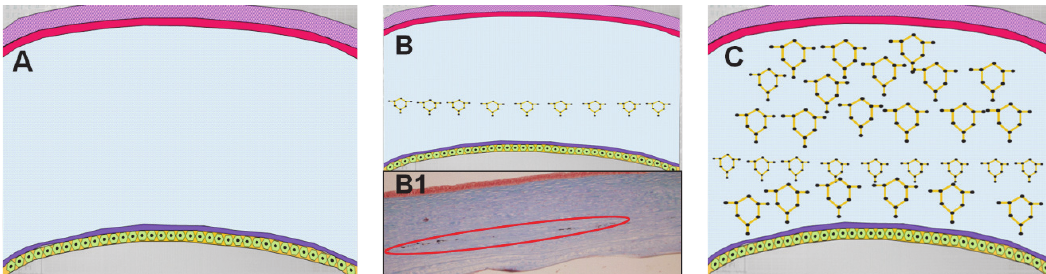
Figure 8: Schematic representation of a cross section of the cornea. (A) Cornea without carbon nanostructures. (B) Cornea with carbon nanostructures in the area where the pocket was created as it was performed in the current study. (B1) Histopathology sample stained with Masson trichrome corresponding to one of the corneas analyzed in the present work where carbon nanostructures can be found just in the area where the stromal pocket was created (red circle). (C) Schematic representation of the cross section of the cornea with an increased distribution of carbon